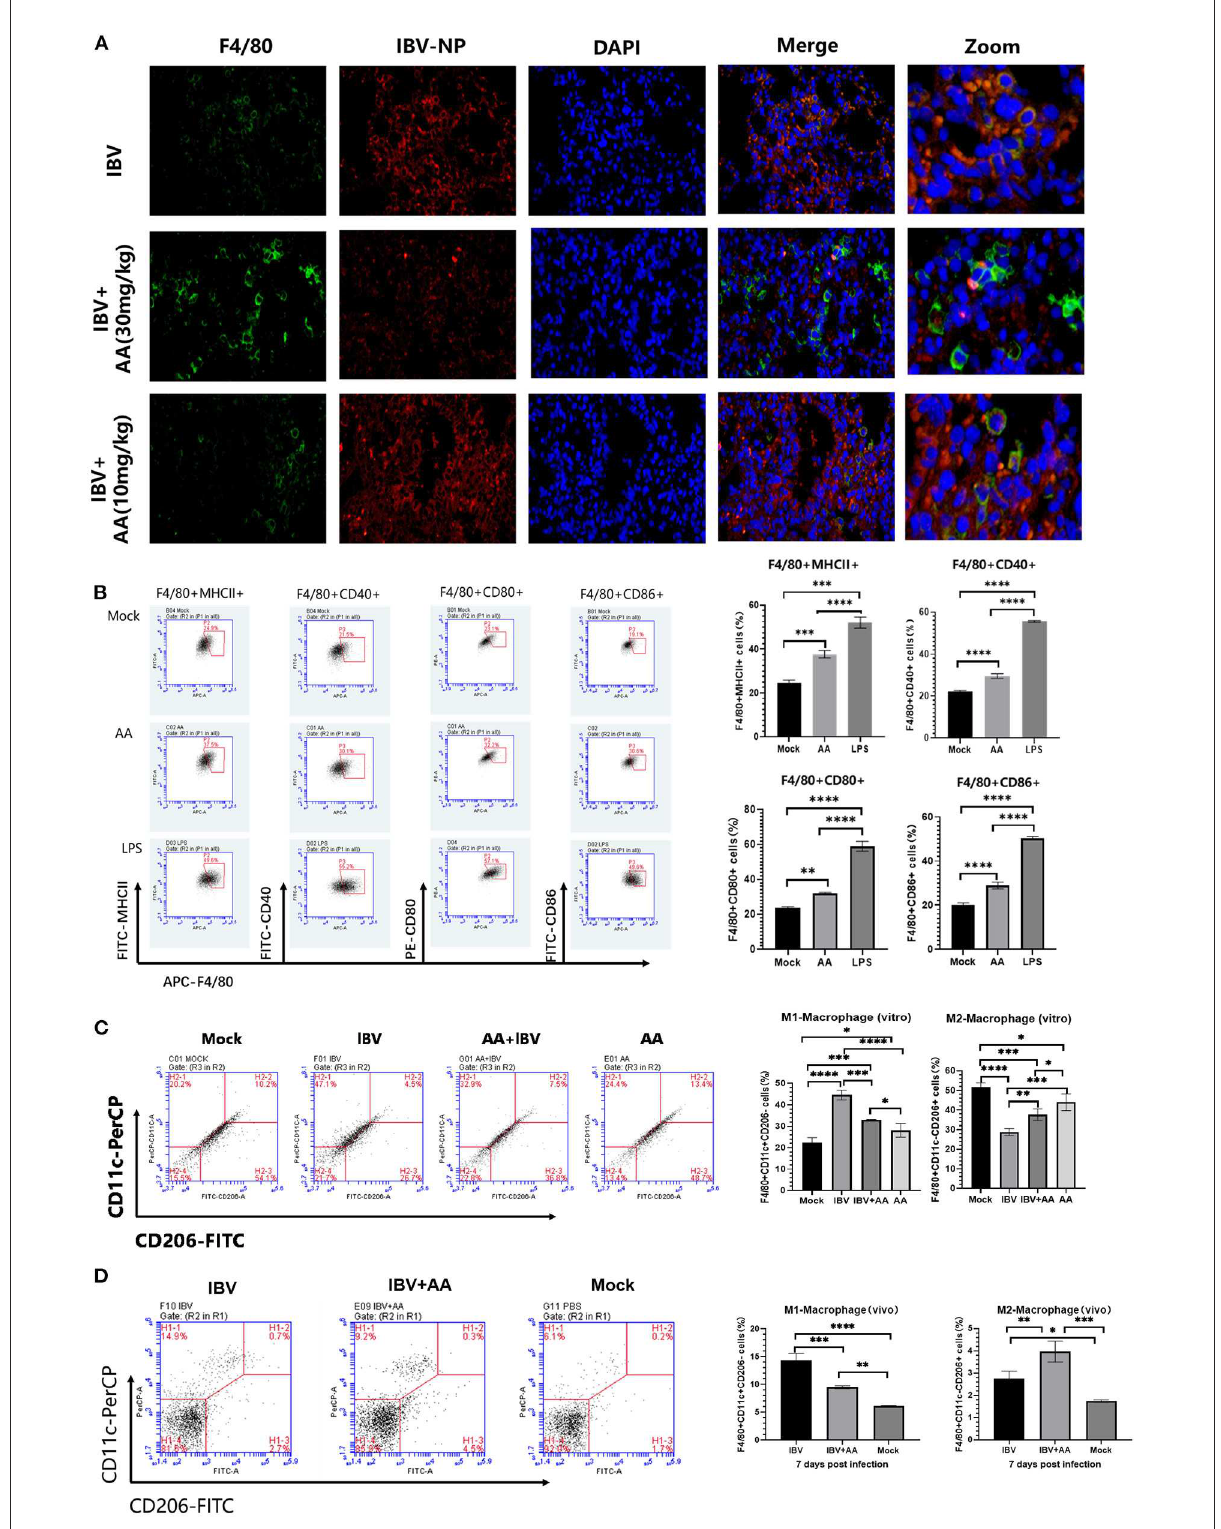
FIGURE5 Levels of activation and polarization of macrophages. (A) Immunofluorescence analysis of lung tissue after infection. The intensity of green (FITC) fluorescence represents the expression of F4/80 protein, while the intensity of red (APC) fluorescence represents the expression of IBV nucleoprotein. (B) The analysis of Atractyloside A induced macrophage activation. Flow cytometry was performed to analyze the proportions of